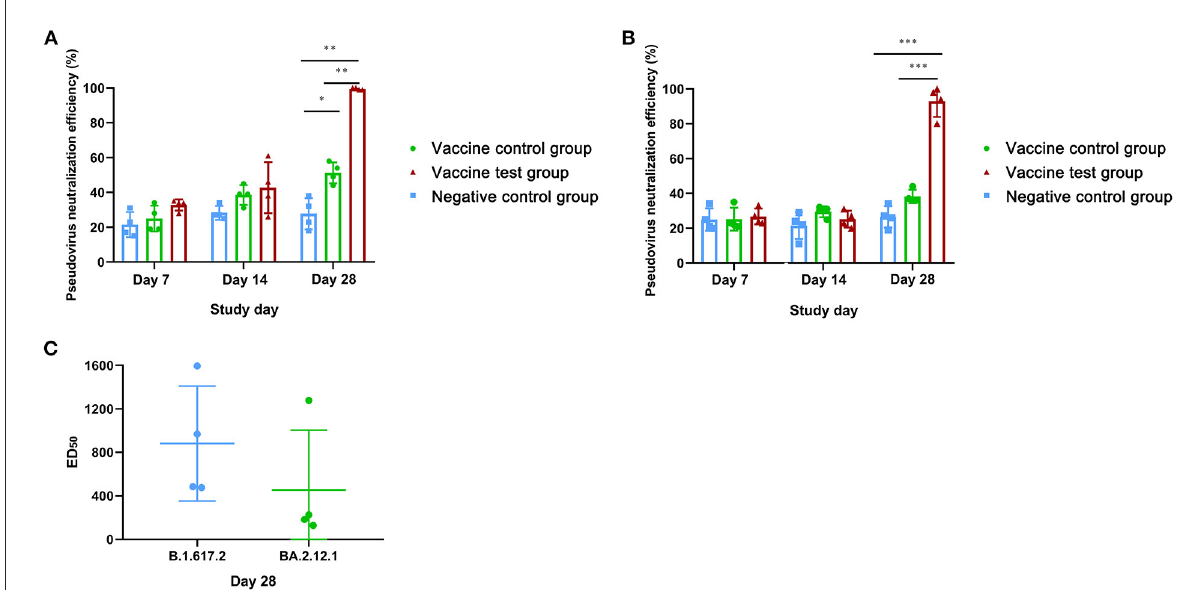
FIGURE4 Neutralization efficiencies of mice serum neutralizing antibodies against pseudovirus of SARS-CoV-2 (B.1.617.2) and SARS-CoV-2 (BA.2.12.1). (A) Neutralization efficiencies of mice serum neutralizing antibodies against SARS-CoV-2 (B.1.617.2) pseudovirus in three groups at day 7, 14, and 28. (B) Neutralization efficiencies of mice serum neutralizing antibodies against SARS-CoV-2 (BA.2.12.1) pseudovirus at day 7, 14, and 28. (C) The comparison of ED 50 of neutralization efficiencies between SARS-CoV-2 (B.1.617.2) pseudovirus and SARS-CoV-2 (BA.2.12.1) pseudovirus in vaccine test group on day 28 (Vaccine test group, n = 4; Vaccine control group, n = 4; Negative control group, n = 4; * p < 0.05; ** p < 0.01; *** p < 0.001; p < 0.05 was considered statistically